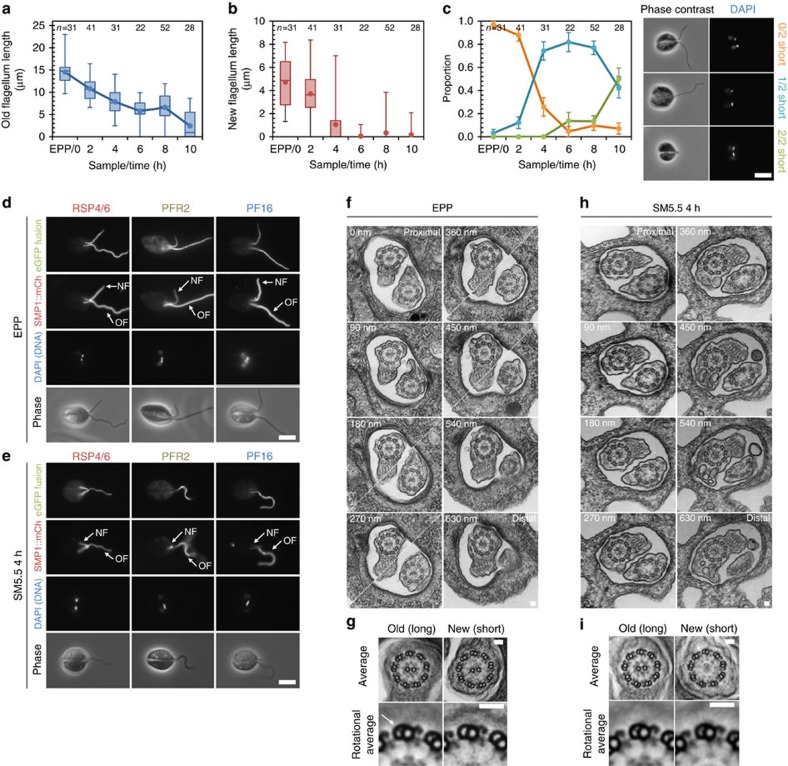
Axonemes formed de novo are 9+0 and grow next to an existing 9+2 flagellum.(a) Longer (older) flagellum length on dividing (1K2N and 2K2N) cells following transfer of EPPs to SM5.5. (b) Shorter (newer) flagellum length on dividing cells following transfer of EPPs to SM5.5. Points represent the mean and box, and whiskers represent median, quartiles and 5th and 95th percentiles in a,b. (c) Proportion of dividing cells with zero, one or two short flagella (<1 μm) following transfer of EPPs to SM5.5. Error bars indicate standard error of proportion. Example phase contrast and DAPI fluorescence micrographs of the three classes of dividing cell are shown. Data in a–c are representative of two independent experiments. (d,e) Native fluorescence micrographs of dividing cells expressing eGFP fusions of known axonemal proteins from our first panel of cell lines; (d) as EPPs with zero short flagella and (e) cells with one short flagellum 4 h after transfer to SM5.5. Axoneme composition was identical in both EPP flagella; 4 h after transfer to SM5.5, PFR2::eGFP and PF16::eGFP did not localize to the short, new flagellum (NF). Scale bars in c–e represent 5 μm. (f) TEMs of serial sections through the two flagella in the flagellar pocket (FP) of a single dividing EPP. Diagonal dashed lines indicate that the image is a composite of two different sample tilt angles. (g) Axoneme averages and detail of doublets after Markham rotational averaging of the old and new flagellum. The only structural difference between the new and old axoneme was the absence of ponticuli (arrow) from the lumen of the B-tubule of outer doublets in the new flagellum. (h) TEMs of serial sections through the two flagella in the FP of a single dividing cell 4 h after transfer of EPPs to SM5.5. The central pair is absent from the new flagellum. (i) Axoneme averages and detail of doublets after Markham rotational averaging of the old and new flagellum. The only structural differences are the absence of ponticuli and central pair in the new flagellum. f,g and h,i are each representative of five cells. Scale bars in f–i represent 50 nm.